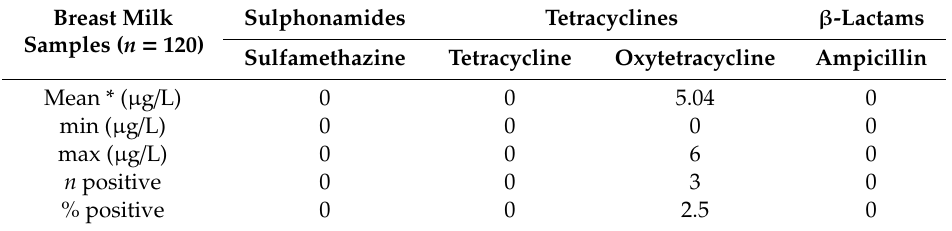
Table 5. Occurrence of sulphonamides, tetracyclines, and β -lactams in the 120 breast milk samples. Breast